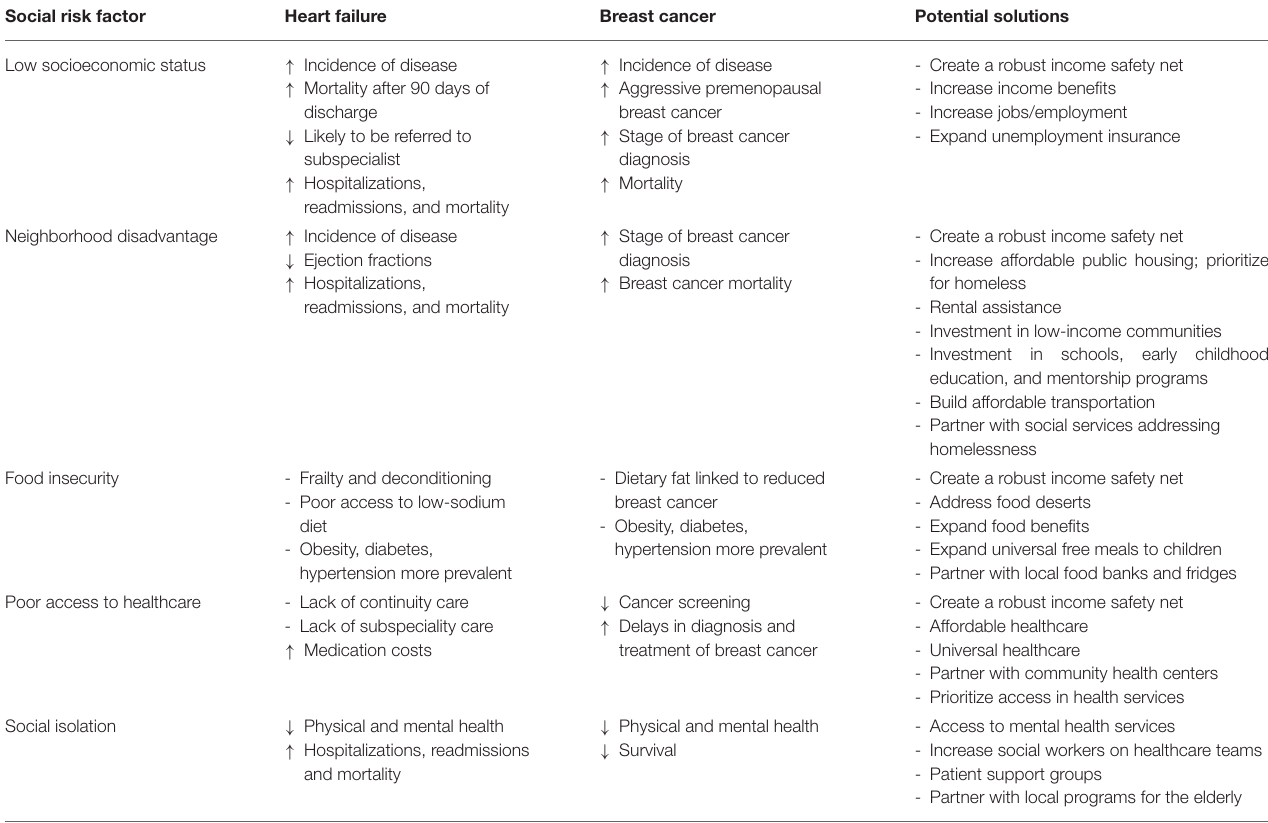
TABLE 2 | Common social risk factors between heart failure and breast